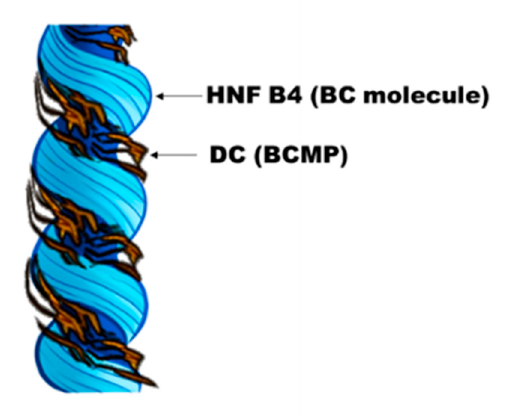
Figure 6. ( a ) Typical induced CD spectra of pure HNF B4 (BC molecule), pure DC (BCMP), and <B4/DC> (binary mixture) (inset: absorbance spectra of pure HNF B4 (BC molecule) and pure DC (BCMP)). ( b ) POM images of <B4/DC> taken by rotating the cell about cell surface normal under uncrossing conditions.